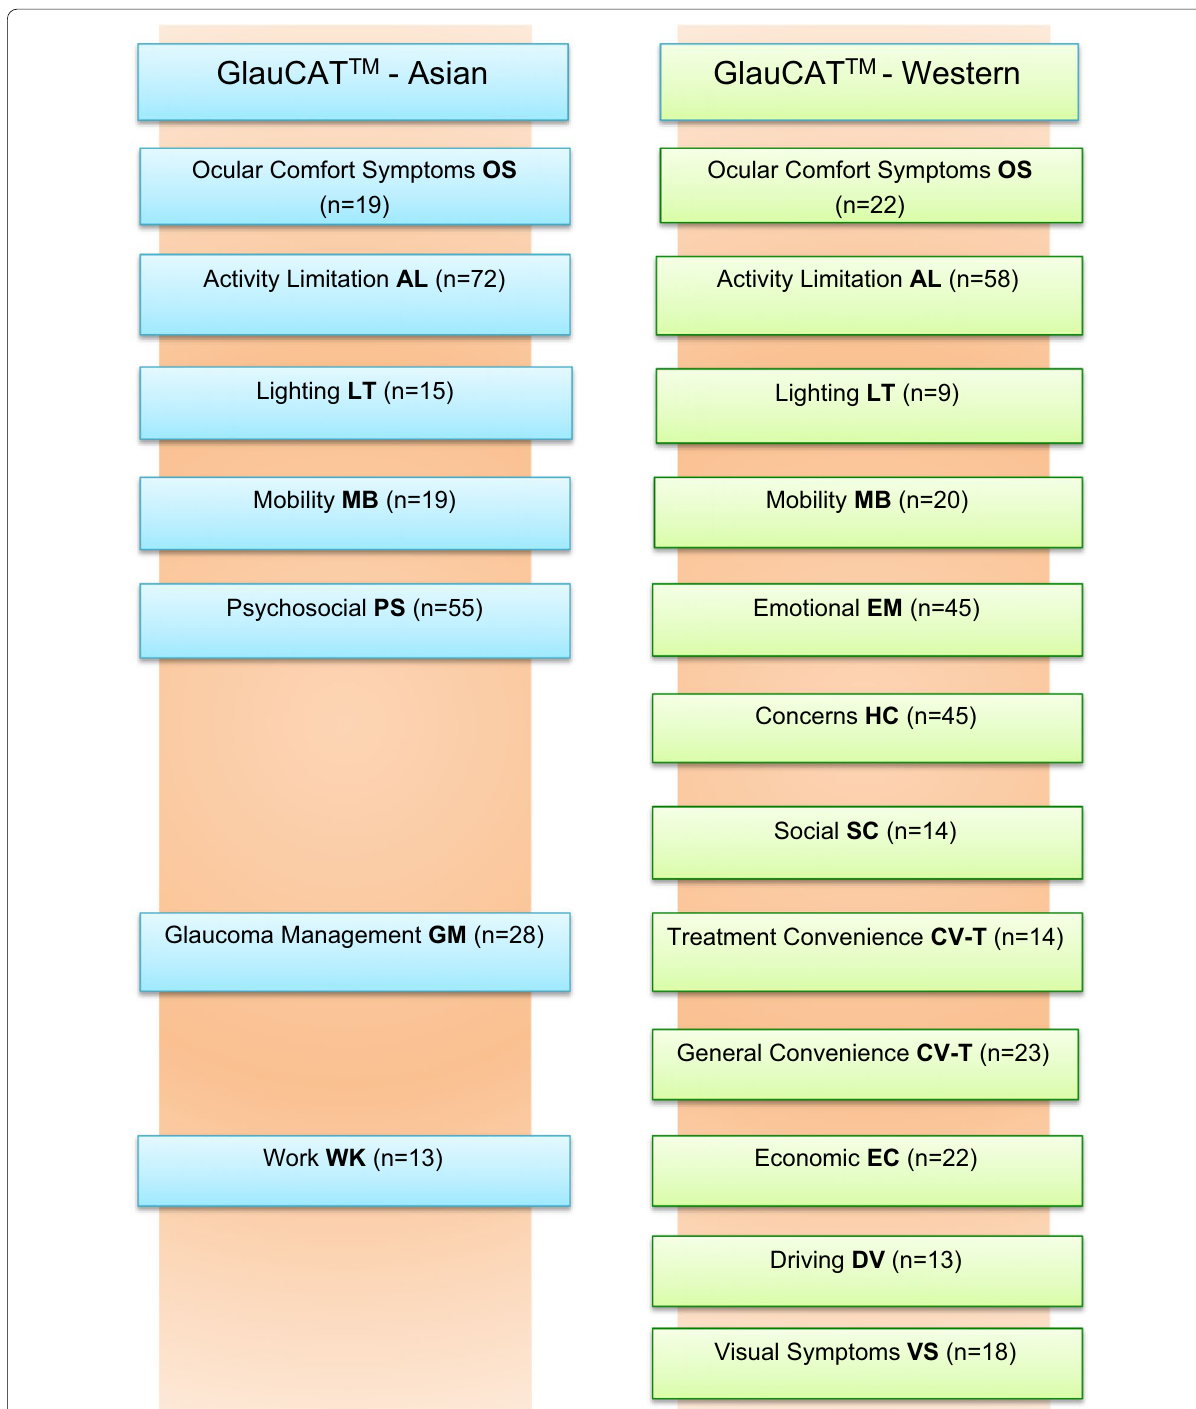
Fig. 1 Head-to-head comparison of the domain structure of the new GlauCAT ™ -Asian and GlauCAT ™ -Western instruments. This figure shows that four domains—OS, AL, MB and LT—are the same across the two instruments, while the number and content of the remaining domains